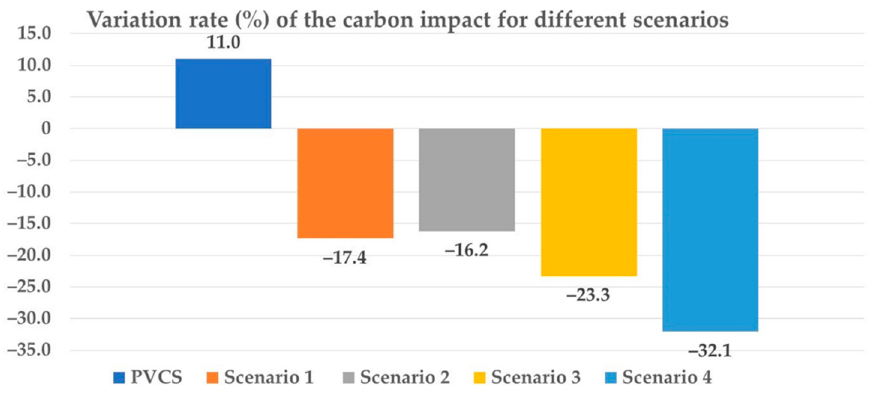
Figure 12. Variation rate for the different scenarios.